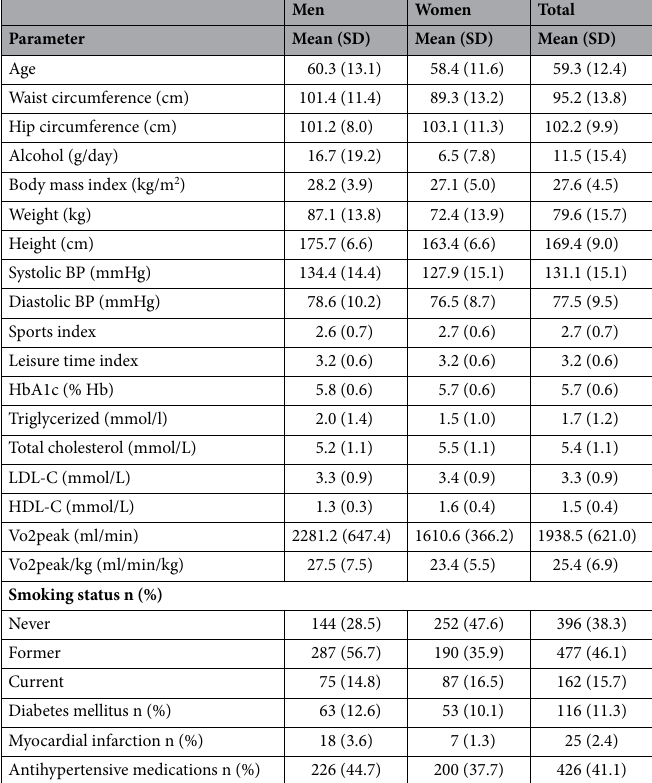
Table 1. Descriptive statistics of the study population. HbA1c glycated hemoglobin, LDL-C low density lipoprotein cholesterol, HDL-C high density lipoprotein cholesterol, VO2peak peak oxygen uptake, VO2peak/ kg body weight adjusted peak oxygen uptake, BP blood pressure.